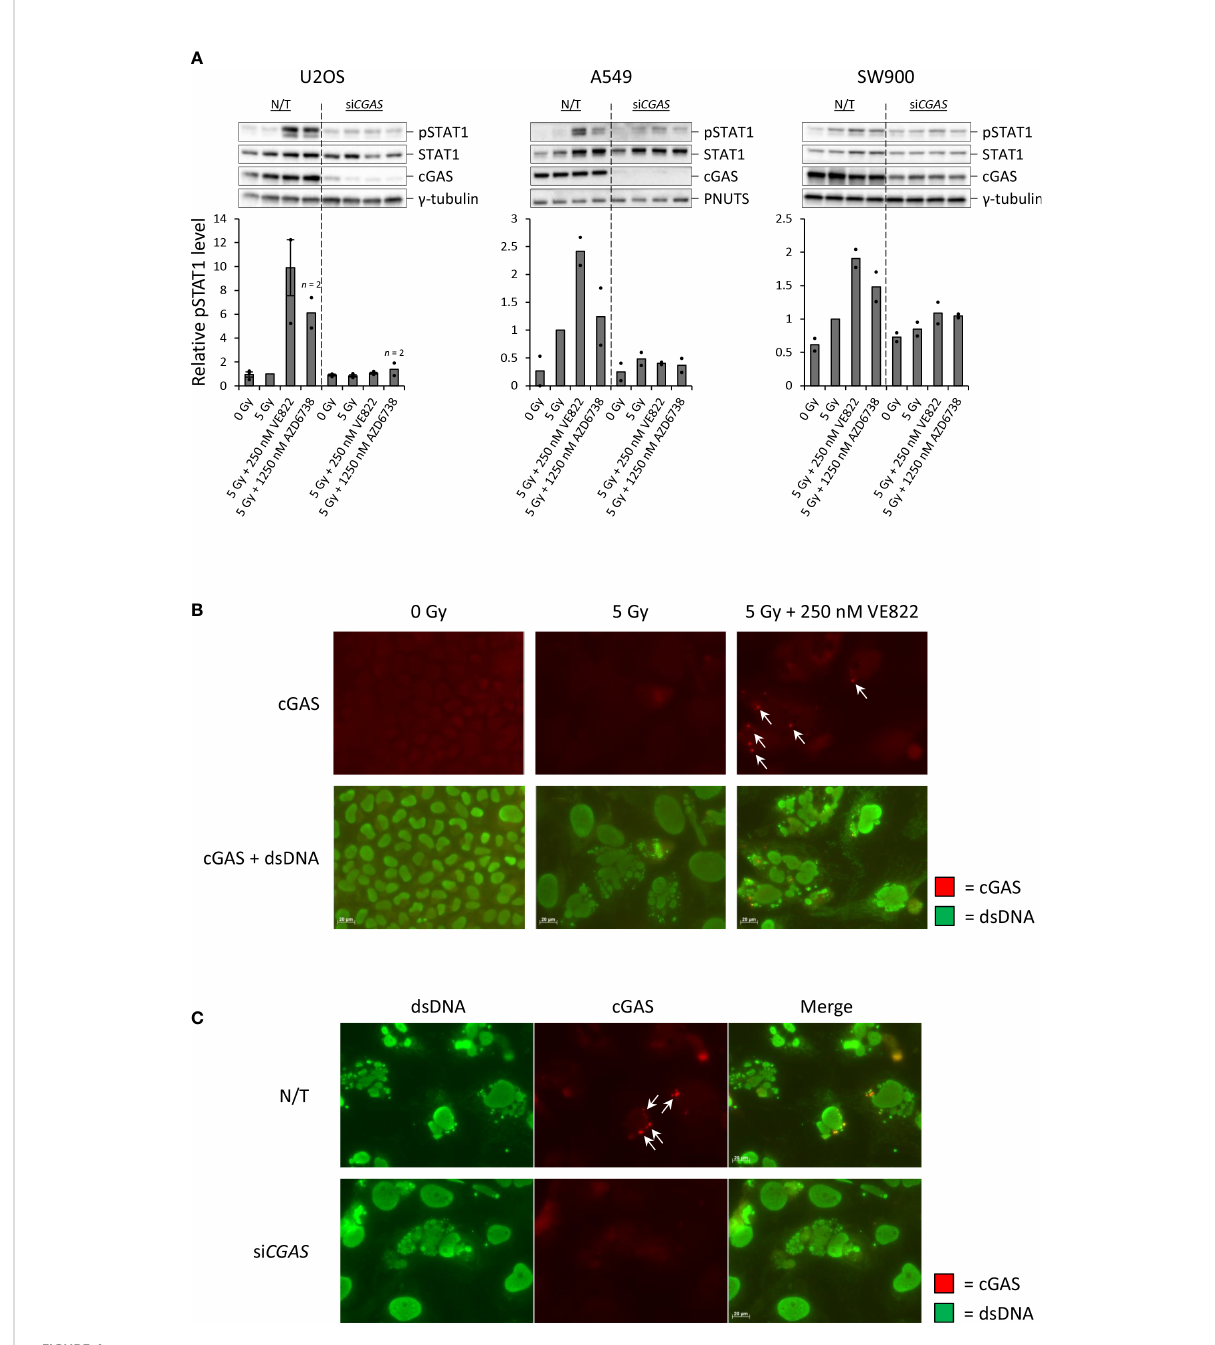
FIGURE 4 Increased IFN signaling after IR and ATRi is dependent on the cytosolic DNA sensor cGAS. (A) Immunoblots and quanti fi cations of pSTAT1 levels in non-transfected (N/T) and si CGAS -transfected cells at three (U2OS, SW900) or six (A549) days after treatment. Bar charts show pSTAT1 levels relative to loading controls ( g -tubulin or PNUTS) and normalized to 5 Gy. (B) Micrographs of U2OS cells stained with antibodies against cGAS (red) and dsDNA (green) at three days after treatment. (C) Micrographs of U2OS cells transfected with si CGAS as in (A) and harvested at three days after treatment with 5 Gy and 250 nM VE822. Arrows in Figure B-C indicate cGAS foci localized to micronuclei. Scale bars: 20